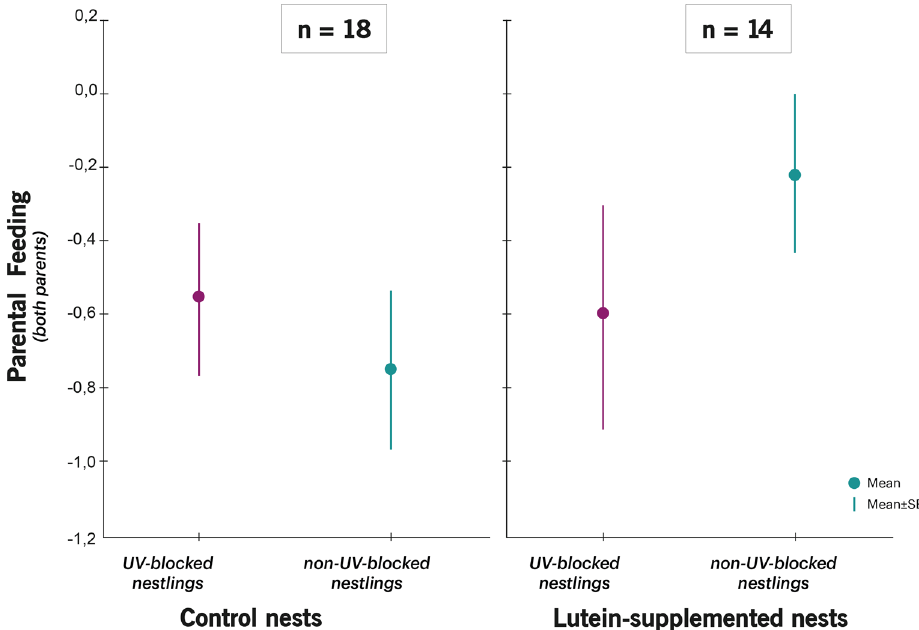
Figure 1. Difference in parental feeding rates (Post UV manipulation − Prior UV manipulation) according to nestling UV colour manipulation and female supplementation treatment. Values are (mean ± SE) residuals plus the average difference in feeding rates from a model that includes all variables except the interaction between both treatments. Sample sizes for control females and lutein-supplemented females are shown.